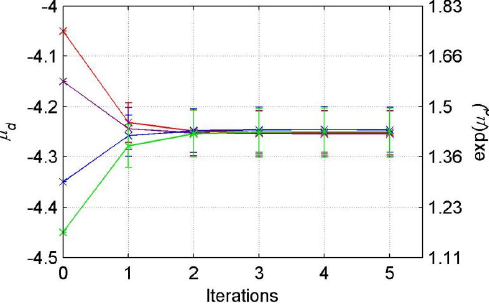
Fig. 5. Evolution of the derived layer thickness parameter µ d as Fig. 5: Evolution of the derived layer thickness parameter µ d as function of the number of EM 2 function of the number of EM iterations, when given incorrect in- iterations, when given incorrect input values of this parameter. Median of the resulting layer 3 put values of this parameter. Median of the resulting layer thick- thickness distribution is calculated as exp( µ d ). Data points are based on ensembles of 200 4 ness distribution is calculated as exp (µ d ) . Data points are based on ensembles of 200 synthetic data series (sinusoidals produced with synthetic data series (sinusoidals produced with parameters φ = 1, Φ = 0.5 2 , and σ ε2 = 0.5 2 ), 5 parameters ϕ =1, 8 =0.5 2 , and σ 2 ε =0.5 2 ) that each contains ap- that each contains approximately 50 layers. Error bars signify the resulting 1σ spread within 6 proximately 50 layers. Error bars signify the resulting 1 σ spread ensemble members. For the considered range of initial values, the derived value of µ d 7 within ensemble members. For the considered range of initial val- converged to the original input value of µ d =-4.25 after just a few iterations. 8 ues, the derived value of µ d converged to the original input value of µ d = − 4.25 after just a few iterations.